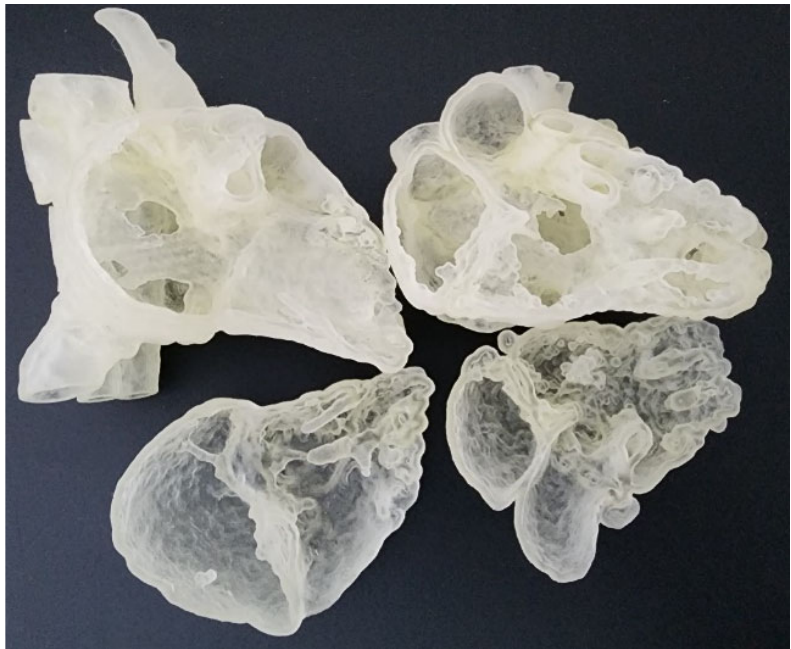
Figure 1. Flexible heart models printed in Agilus 30 featuring atrial septal defect ( left column ) and double outlet right ventricle ( right column ).